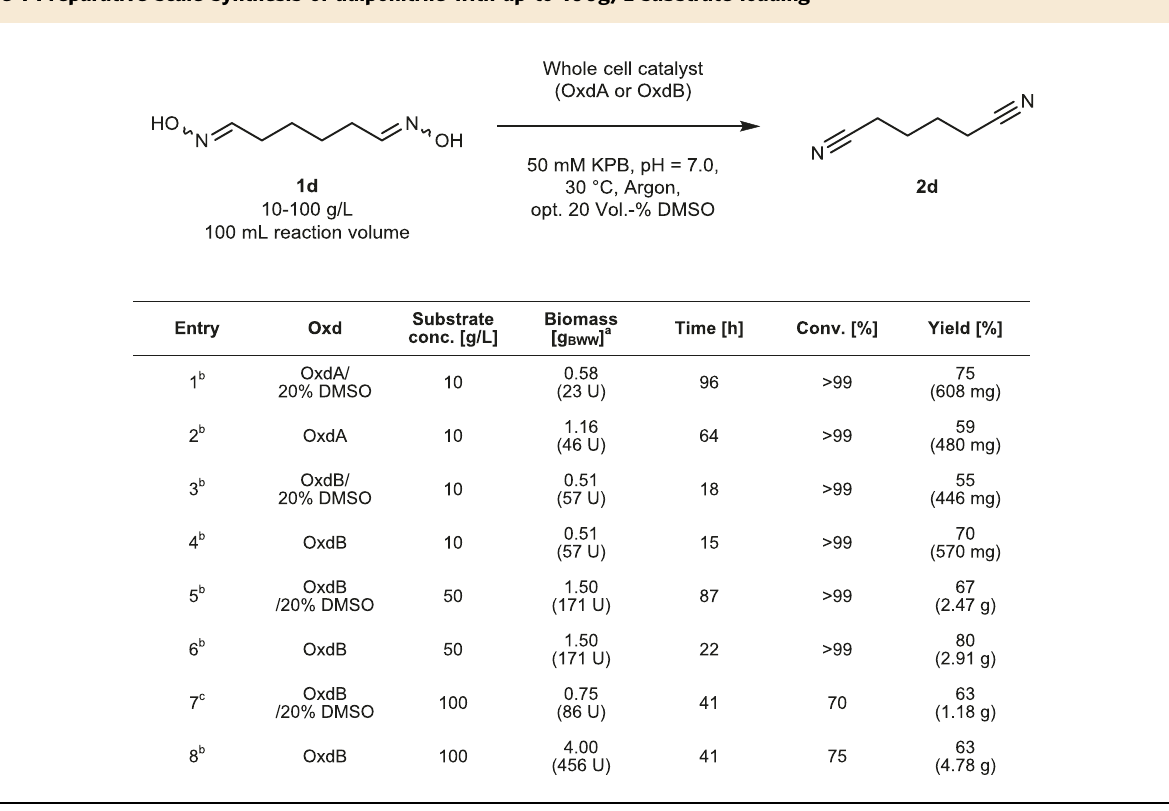
Table 1 Preparative scale synthesis of adiponitrile with up to 100g/L substrate loading